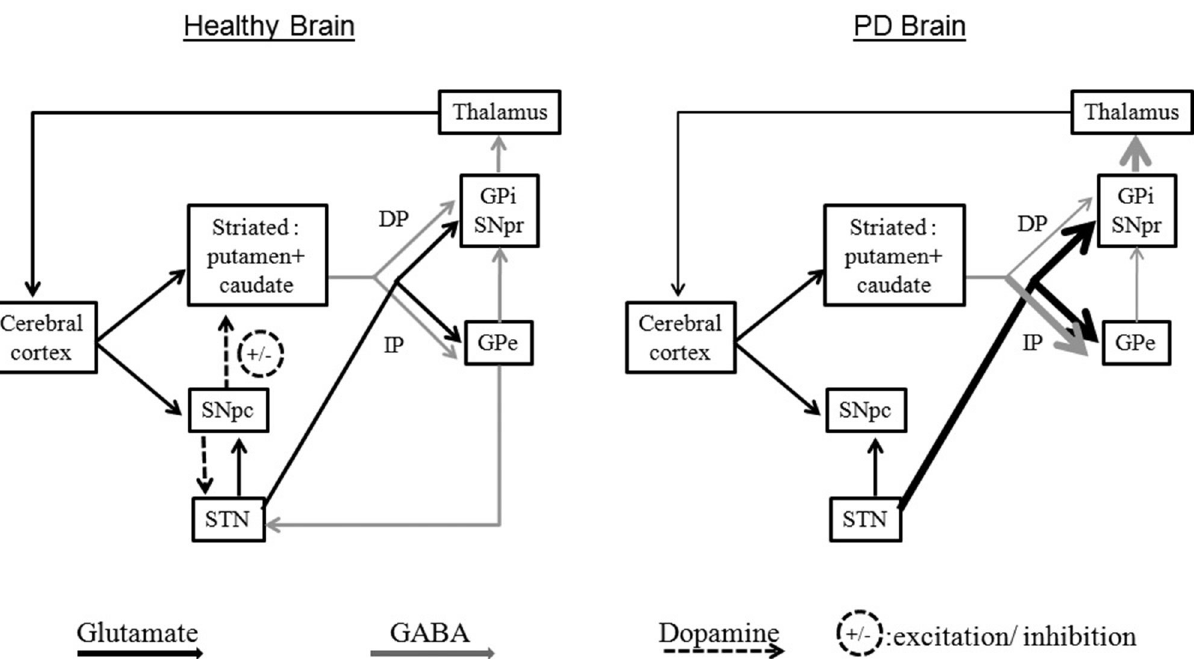
Figure 1. Direct and indirect pathways of the basal ganglia in healthy individual and with PD. Adapted from GOBBI; BARBIERI; VITÓRIO et al., (2014) 18